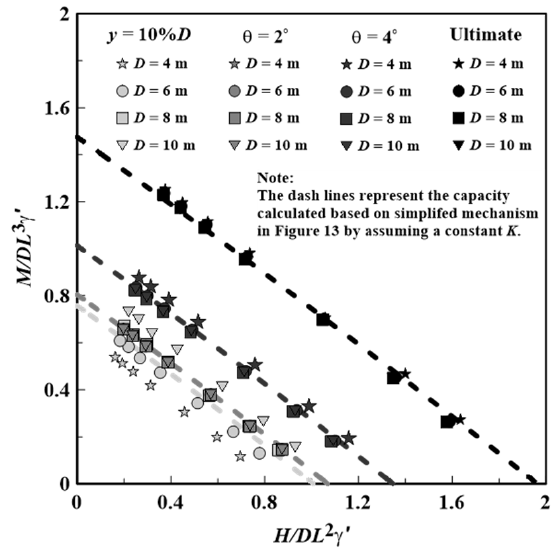
Figure 14. Normalized force–moment diagram of monopiles in 65% relative density sand under different deflection criteria.